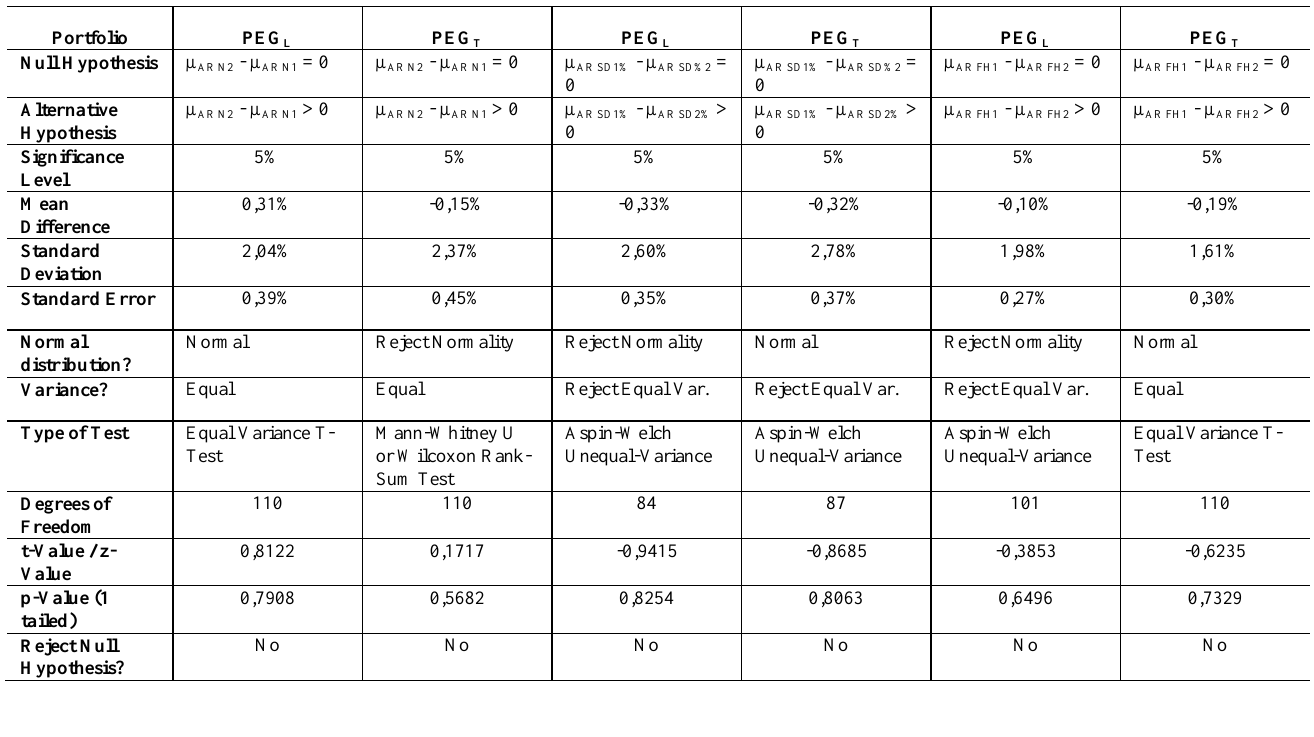
Table 4: Hypothesis test statistics